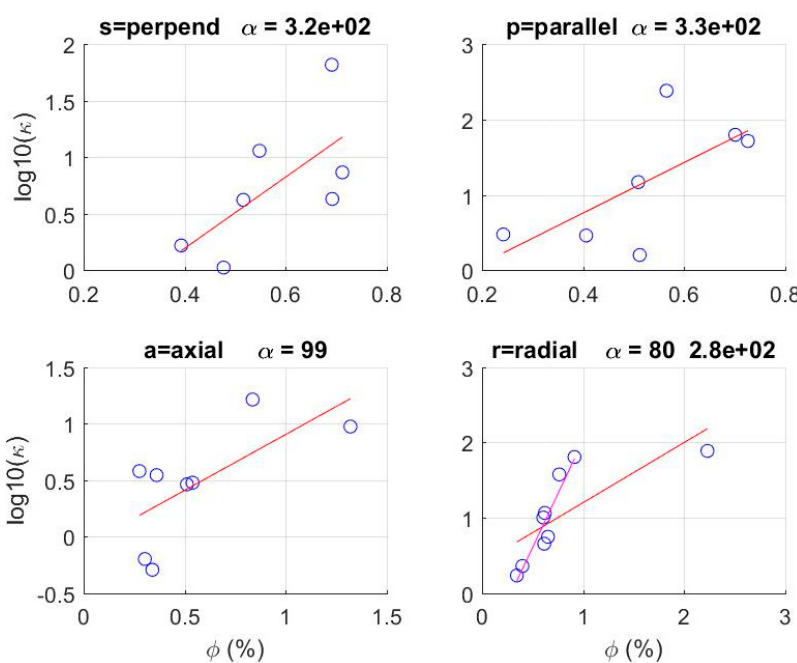
Figure 24. KTB well-core spatial correlation δφ ∝ δ log( κ ); zero-mean/univariance format; φ = blue, δ log( κ ) = red; well-core from depth interval 4000–5500 m [24].